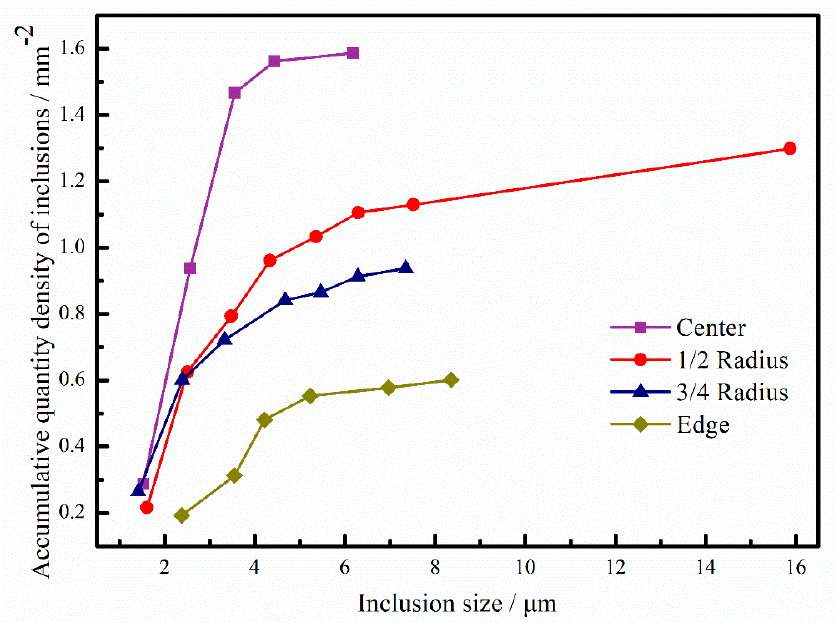
Figure 5. Accumulative quantity density of different sizes of oxide inclusions.